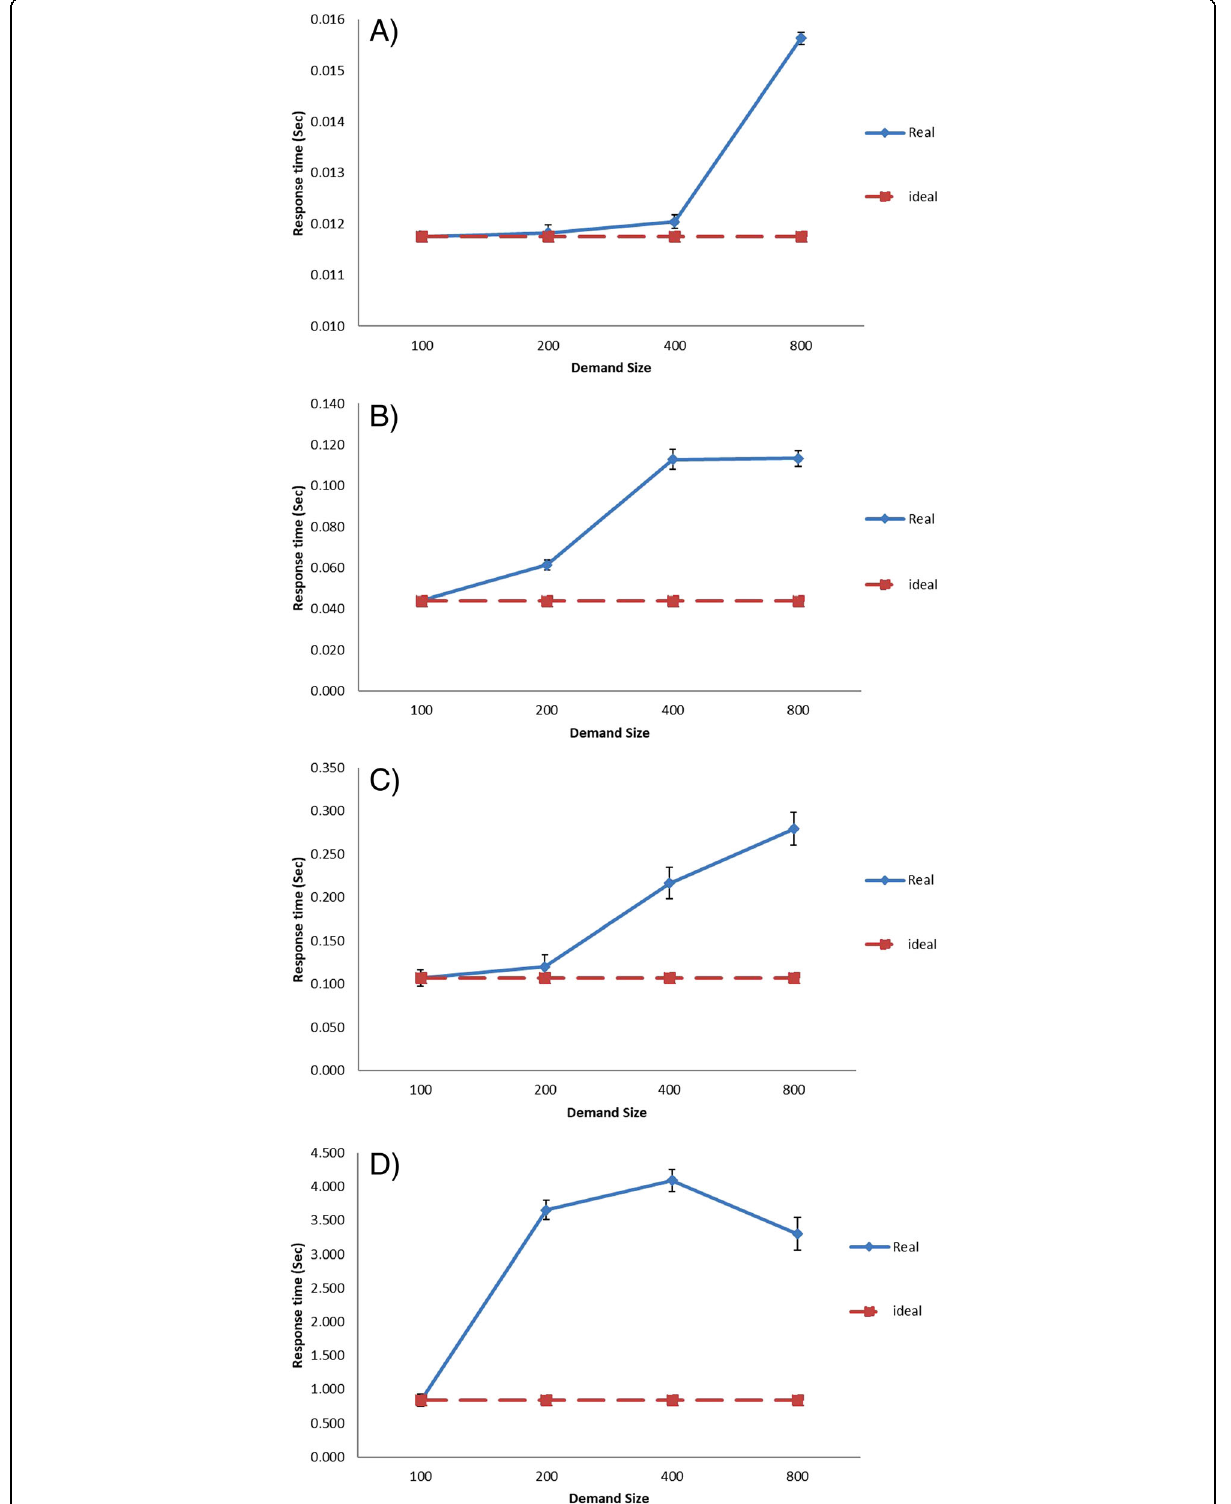
Fig. 7 The average response times. a OrangeHRM/EC2 – Steady rise and fall of demand scenario. b OrangeHRM/Azure - Steady rise and fall of demand scenario. c OrangeHRM/EC2 – Series of step-wise increases and decreases of demand scenario. d OrangeHRM/Azure – Series of step-wise increases and decreases of demand